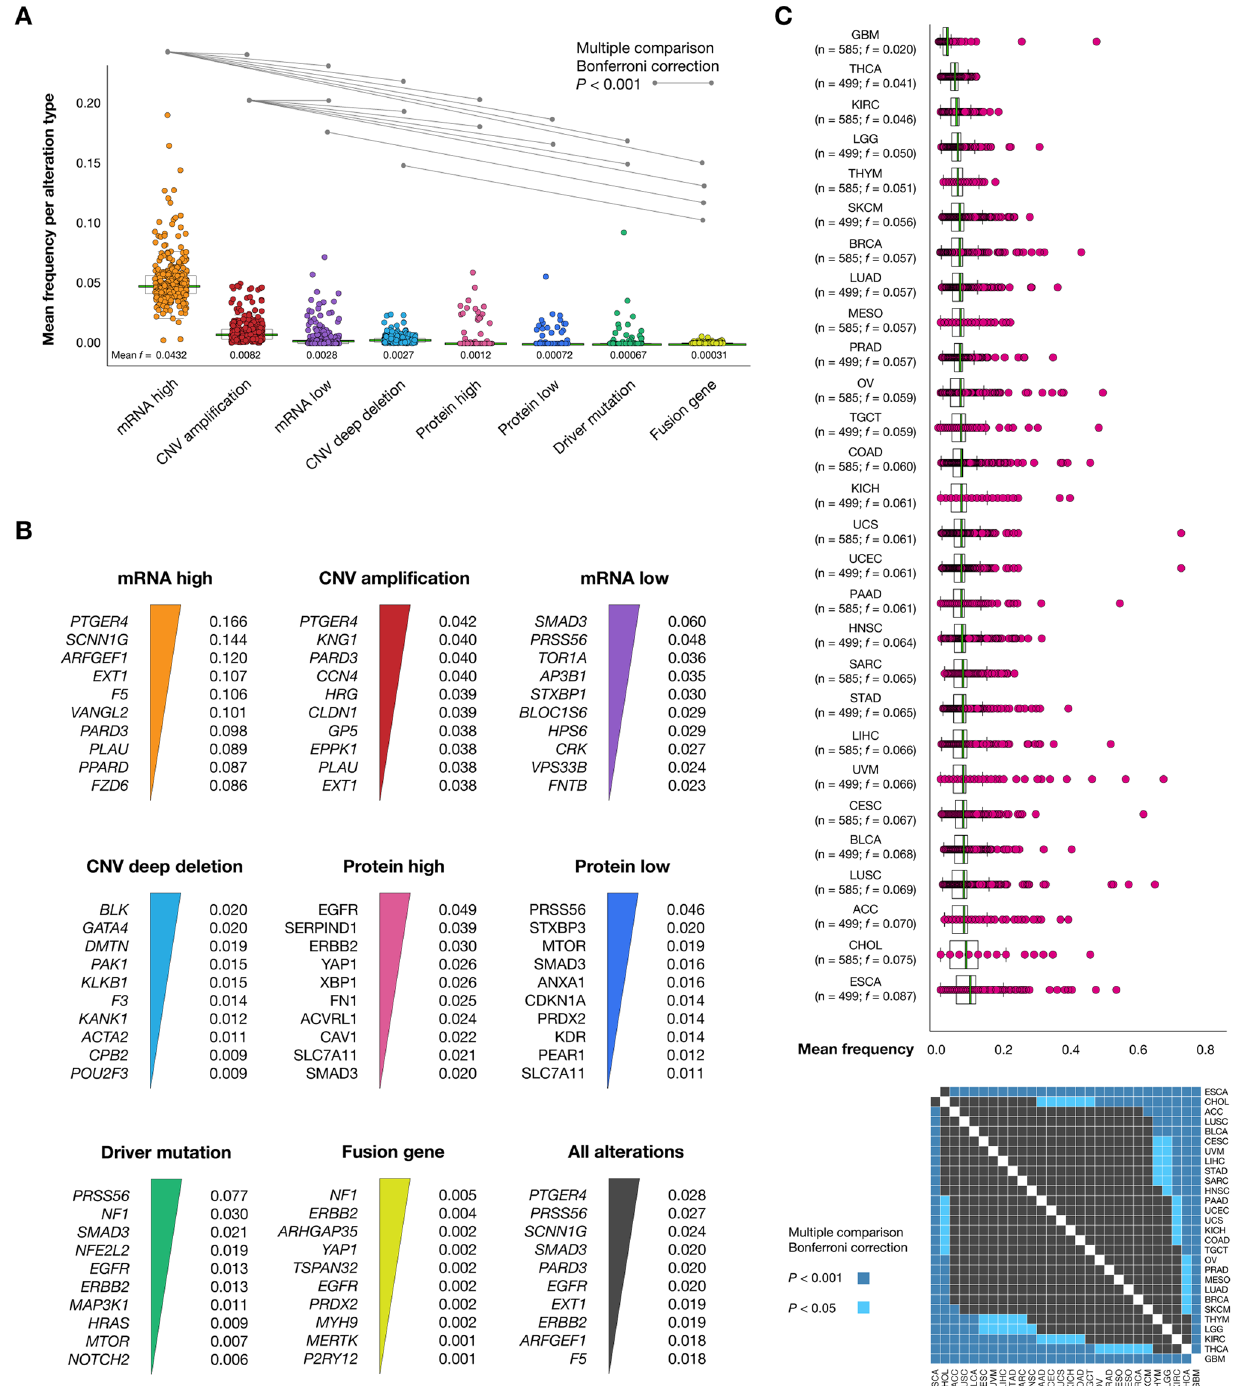
Figure 2. Frequency of genomic, transcriptomic and proteomic alterations per TCGA Pan-Cancer type. ( A ) Mean frequency per alteration type and significant Bonferroni correction ( P < 0.001) of mRNA high, CNV amplification, mRNA low and CNV deep deletion in comparison with other alterations. ( B ) Ranking of the most altered genes/proteins per alteration type. ( C ) Ranking of the most altered TCGA Pan-Cancer types according to the mean frequency of alterations. Lastly, a pairwise map of significant Bonferroni correction ( P < 0.001) across TCGA Pan-Cancer